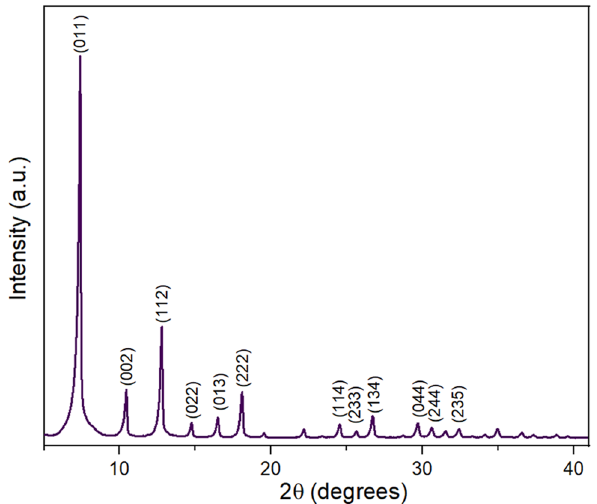
Figure A2: PXRD pattern of ZIF - 8.